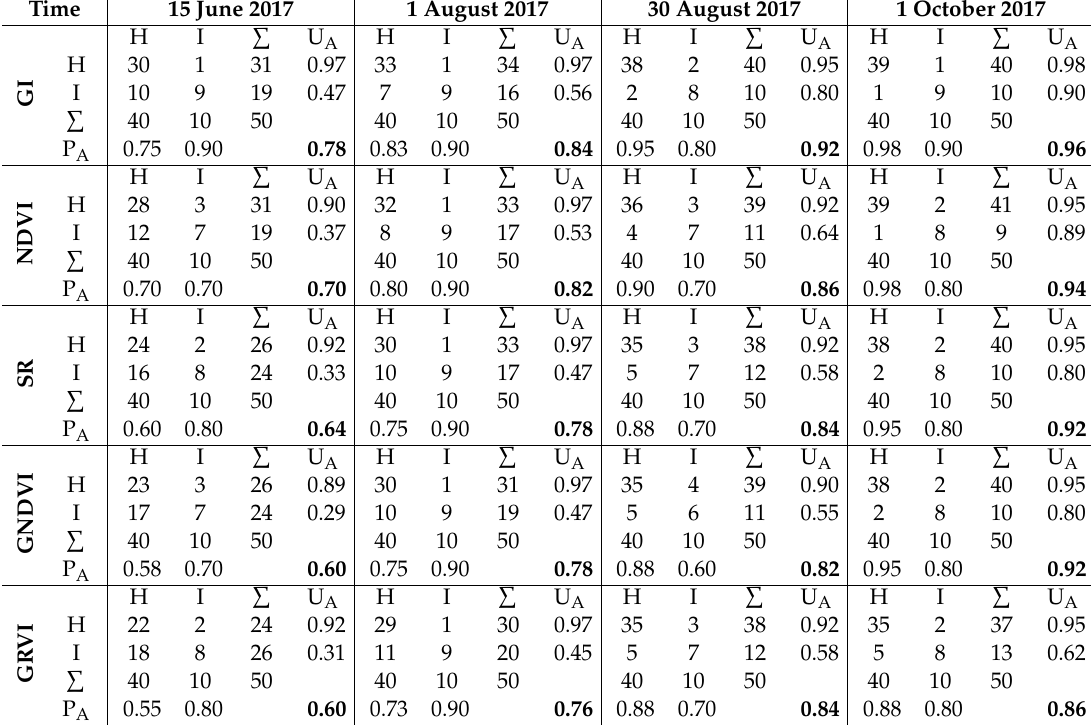
Table 3. Image classification accuracy expressed on a sample of 10 infested:40 healthy trees using maximum likelihood classification where H = number of healthy trees, I = number of infested trees, Σ = sum, P = producer’s accuracy, U = user´s accuracy, bold values = overall accuracy. The graphical A A interpretation of the classification approaches may be found in Figure A2 in Appendix